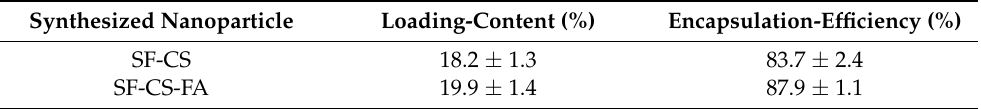
Figure 4. The effect of TPP (mg/mL) on particle size (nm) and PDI index of SF-CS NPs. Table 3. The percentages of LC and EE of SF-CS and SF-CS-FA NPs at the optimum amount of CS, SF, and